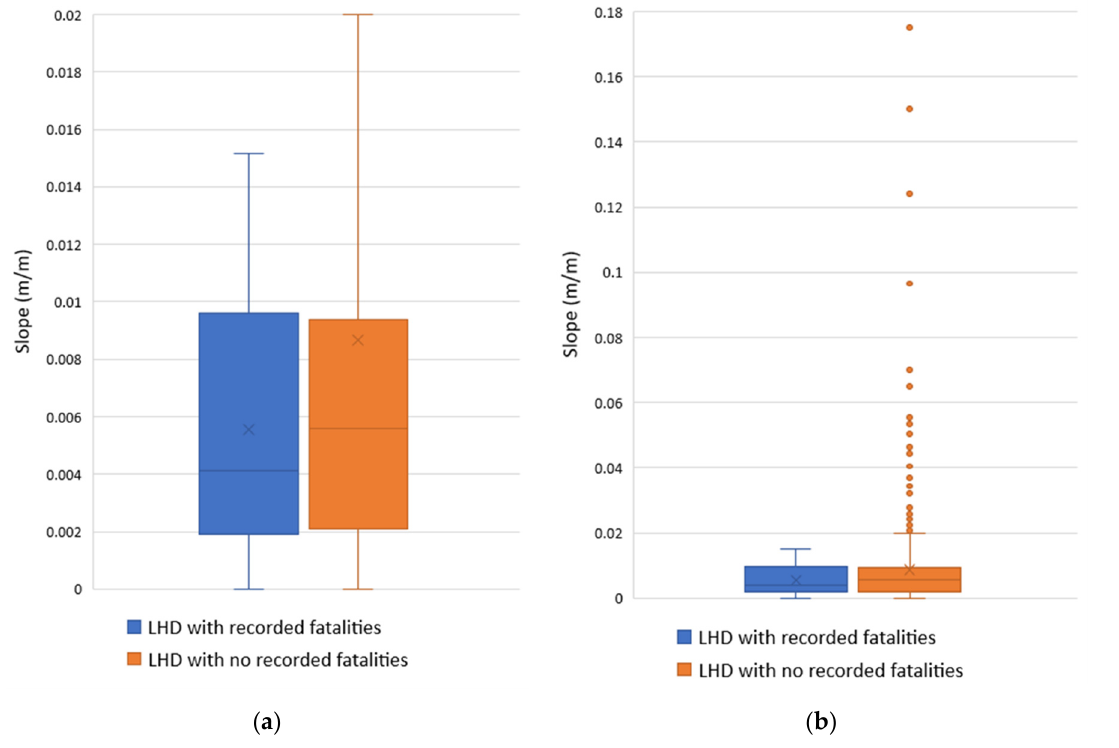
Figure A3. Stream slope at low head dams (LHDs) in Colorado: ( a ) box and whisker plot cutting off the outlier points for low head dams with no recorded fatalities ( b ) The same plot showing the whole range of outlier points for both distributions.